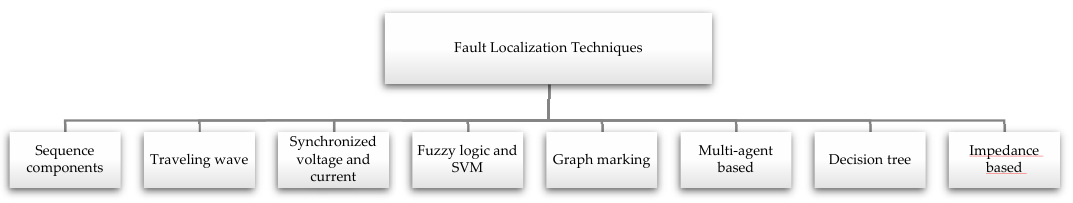
Figure 5. Fault location identifying techniques.